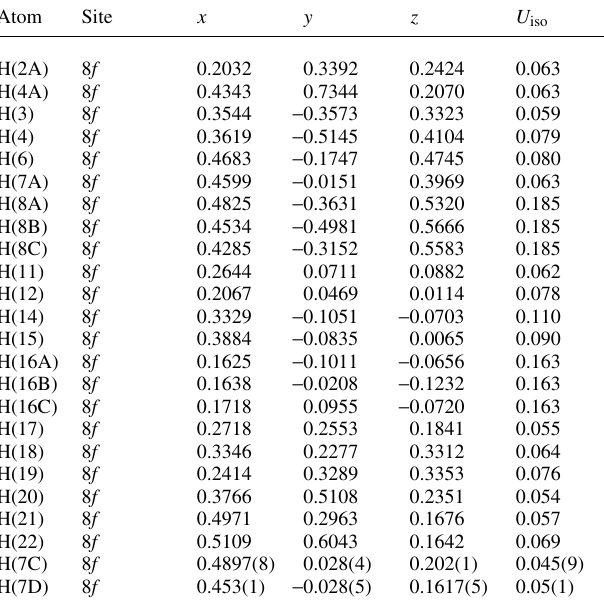
Table 2. Atomic coordinates and displacement parameters (in Å 2 )